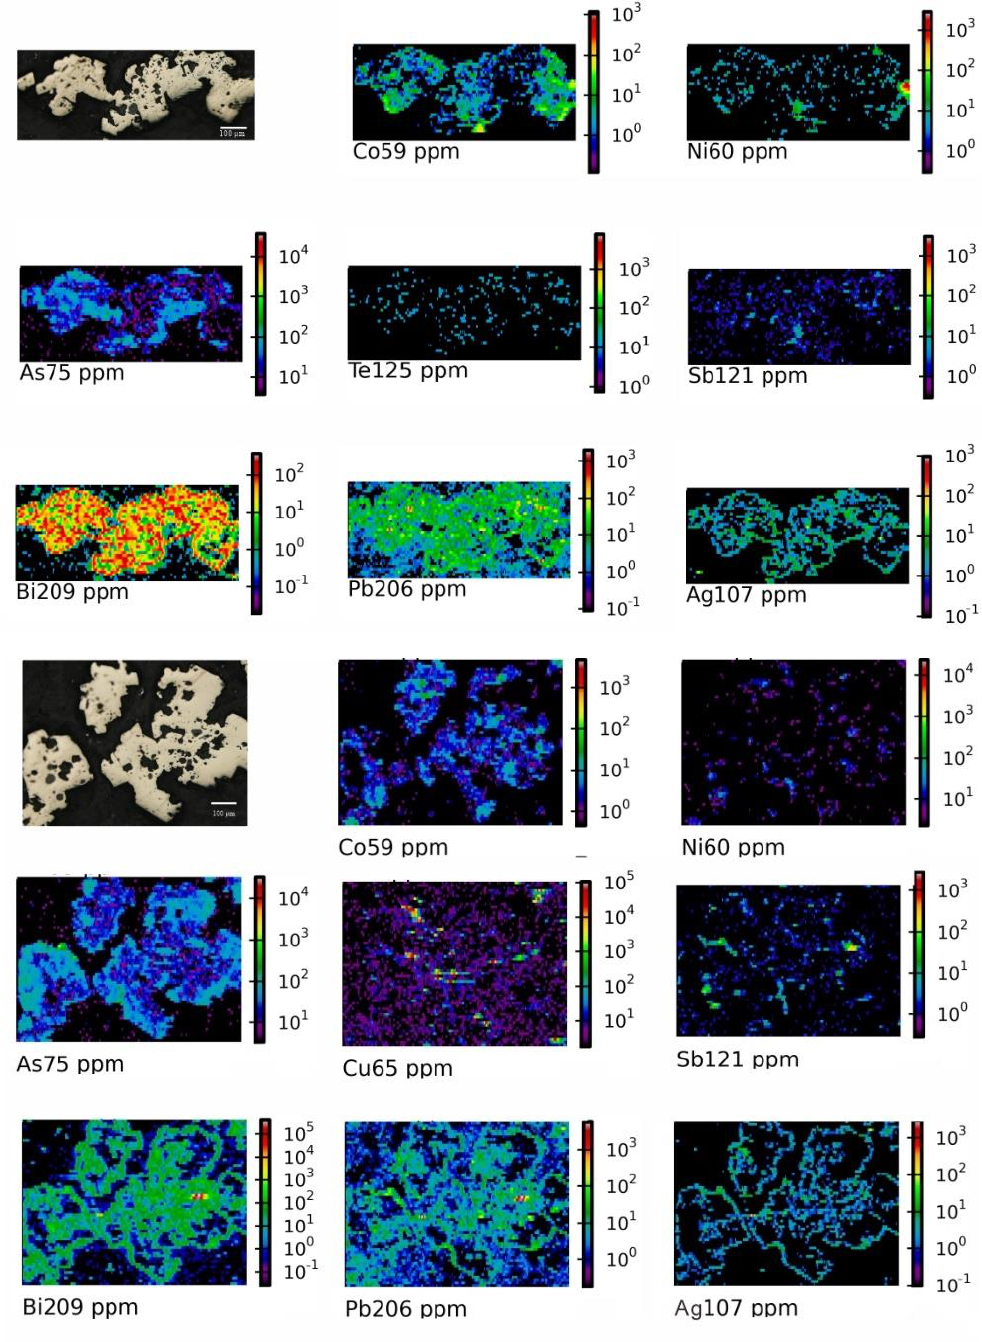
Figure 15. Mapping of pyrite from Sample S8-2.